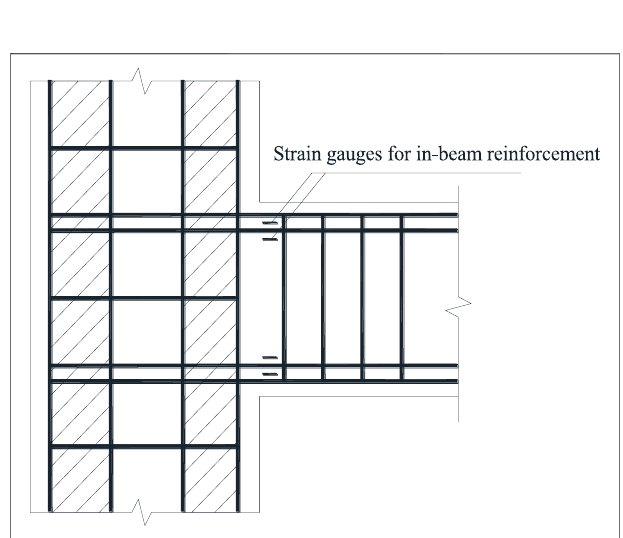
FIGURE 16 | Distribution of strain gauges in beam (Xiang et al., 2017; Xiang et al., 2019).